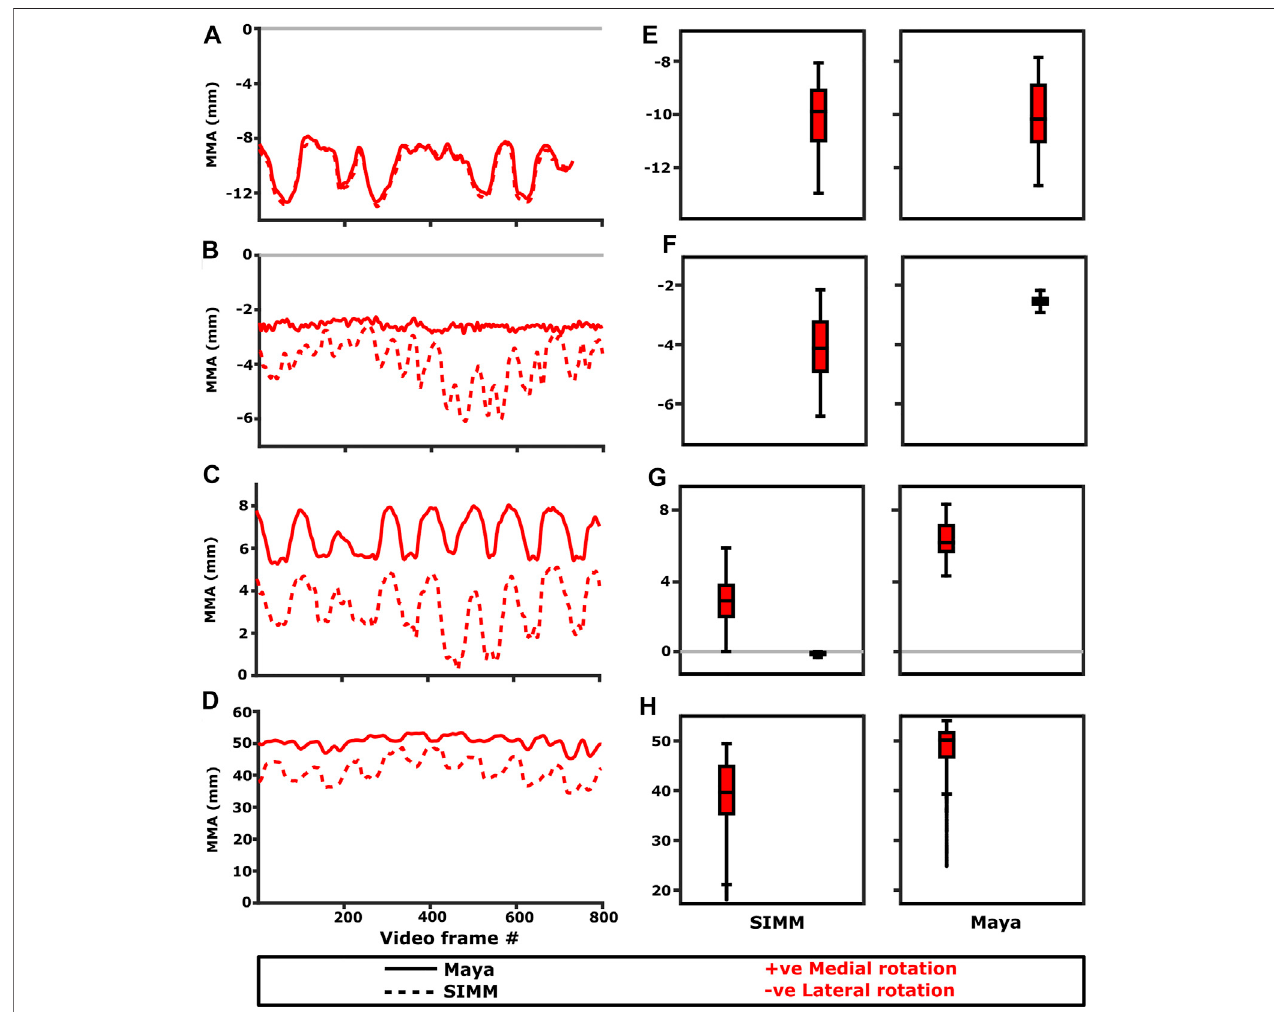
FIGURE 5 | Representative trials (left) and frequency distributions of MMAs for all kinematic trials (right) for muscles crossing the scapulocoracoid-clavicle- interclavicle joint. Representative trials for: (A) m. clavodeltoideus, (B) m. pectoralis cranial origin, (C) m. pectoralis caudal origin, (D) m. latissimus dorsi vertebral origin. The boxplots ( E – H) show the distribution and median values of MMAs for all trials: (E) m. clavodeltoideus, (F) m. pectoralis cranial origin, (G) m. pectoralis caudal origin, (H) m. latissimus dorsi vertebral origin. Positive and negative MMAs are plotted as separate boxplots for each DOF. SIMM (cid:3) model-predicted MMAs based on partial velocity; Maya (cid:3) experimentally-calculated MMAs based on the geometric